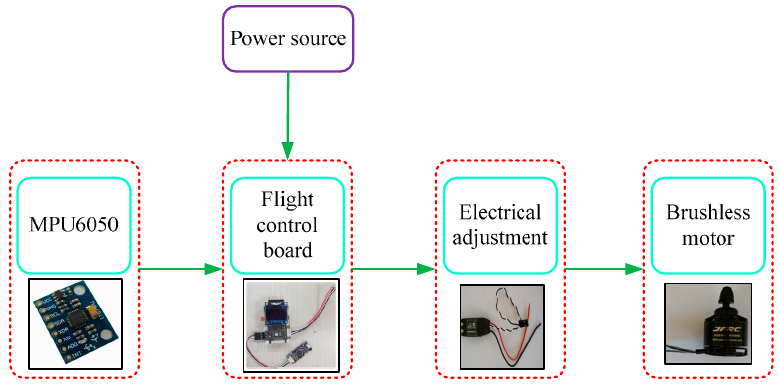
Figure 6. The diagram of the structure of the quadrotor.